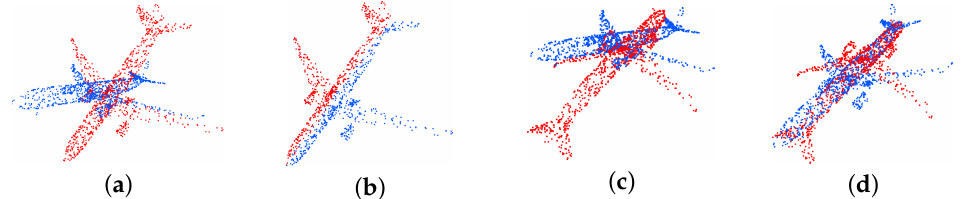
Figure 3. ( a ) Source cloud P (blue), target cloud Q (red) in the initial position; ( b ) result of alignment; ( c ) source cloud P (blue), target cloud Q (red) in the another initial position; ( d ) result of alignment. For the congruent point clouds, we used the threshold (cid:107) M true − M est (cid:107) F = 0.2 as a